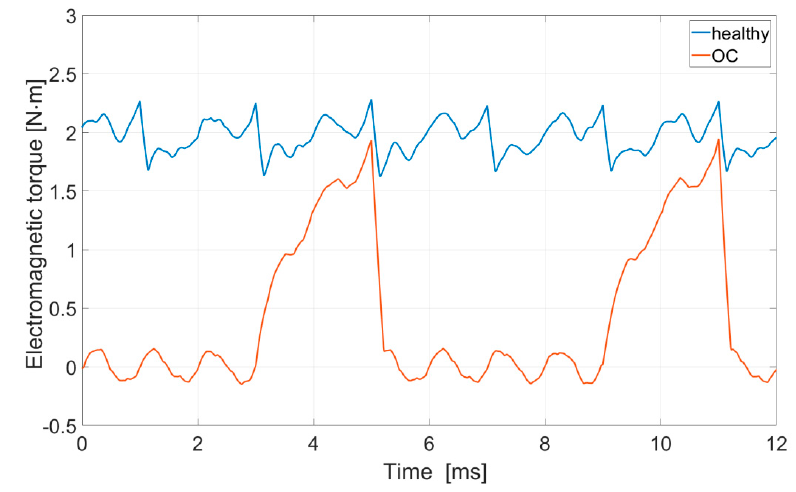
Figure 7. Star (Y) configuration—waveforms of electromagnetic torque.